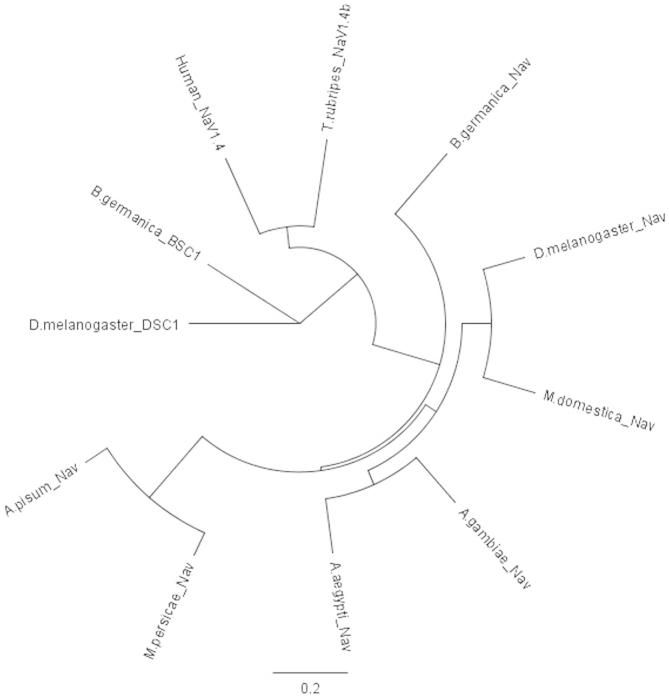
Nav1/Nav2 phylogenetic tree. DNA sequences were imported into BIOEDIT v 7.0.9.0 and converted to amino acid sequence for alignment with ProbCons v1.10. Pal2Nal was utilized to convert the amino acid sequence alignment and the corresponding DNA sequences back into a codon alignment. Codon alignments were subsequently imported into into Geneious (http://www.geneious.com/). A phylogenetic tree was constructed using Geneious Tree Builder with Tamura-Nei as the Genetic Distance Model and Neighbor Joining method, with the DSC1 sequence as outgroup, 1000 bootstrap replicates with random seed was employed to generate a Consensus tree with support threshold cut-off set at 80%.